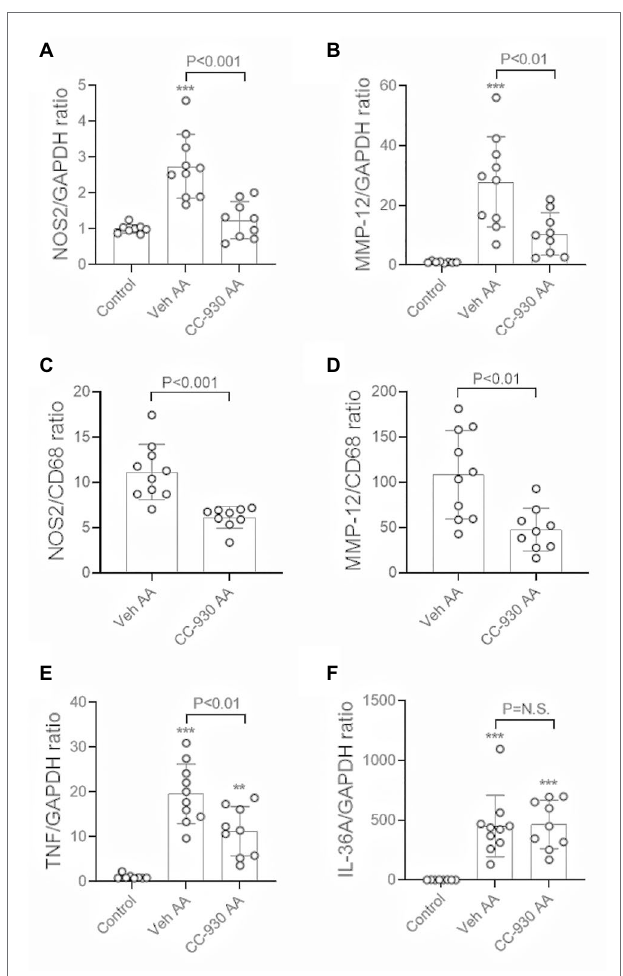
FIGURE 9 | Macrophage activation and inflammation on day 22 of aristolochic acid (AA) induced chronic kidney disease. Vehicle and CC-930 treated AA groups were compared to normal controls. RT-PCR analysis of: (A) NOS2, and; (B) MMP-12. Graphs show the relative mRNA ratio of: (C) NOS2/CD68, and; (D) MMP-12/CD68. RT-PCR analysis of: (E) TNF, and; (F) IL-36A. One-way ANOVA with Tukey’s multiple comparison test, or student’s t -test. ** p < 0.001 and *** p < 0.001 vs. control. N.S., not